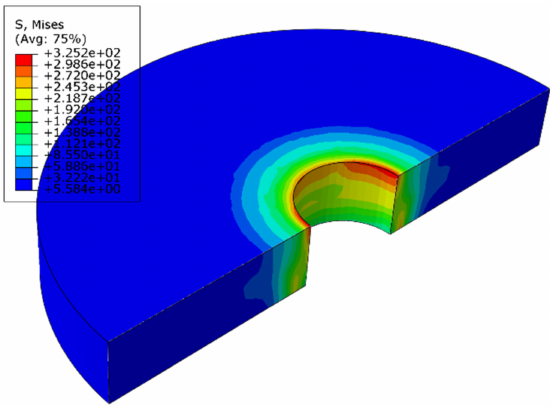
Figure 12. The stress distribution of the connection plate with 3.2% interference. The stress distribution on the hole wall under different interference fit sizes is shown in Figure 14. When the interference fit size is 0.5%, the stress distribution on the hole wall is uniform, the stress value is small, and the hole wall deformation is in a state of elastic deformation. When the interference fit size is 1%, the stress distribution on the